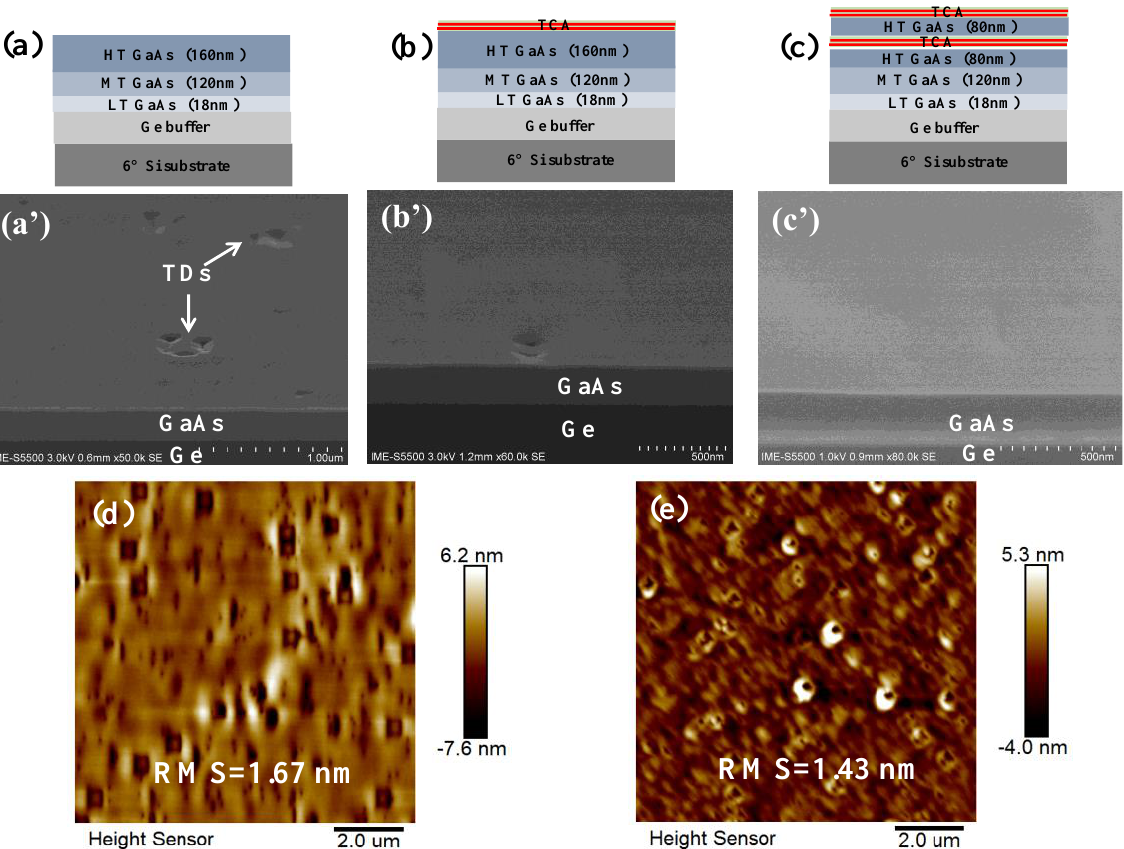
Figure 2 . Schematic of the layered structure of the third step of the GaAs/Ge/Si template grown ( a ) without the TCA step; ( b ) with TCA steps in 0.16 μm -thick HT GaAs; ( c ) with TCA steps in an initially 0.08 μm -thick substrate followed by continuous TCA of the topmost surface of the template. ( a ′ – c ′ ) SEM images of the GaAs surface for the processes of ( a – c ), while ( d , e ) are AFM images of samples a and c (10 × 10 µm 2 area scan).